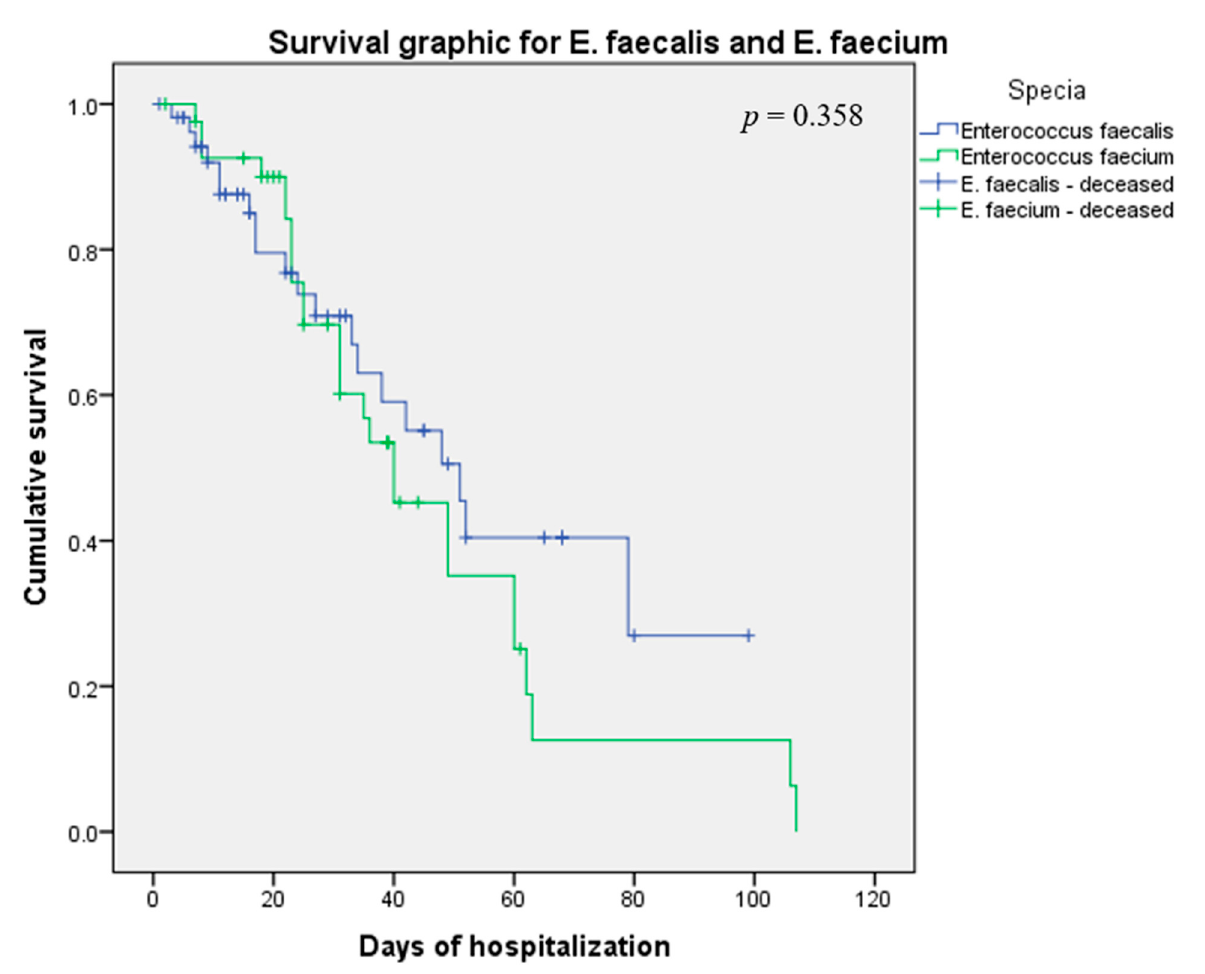
Figure 1. Kaplan Meier survival analysis for E. faecalis and E. faecium.